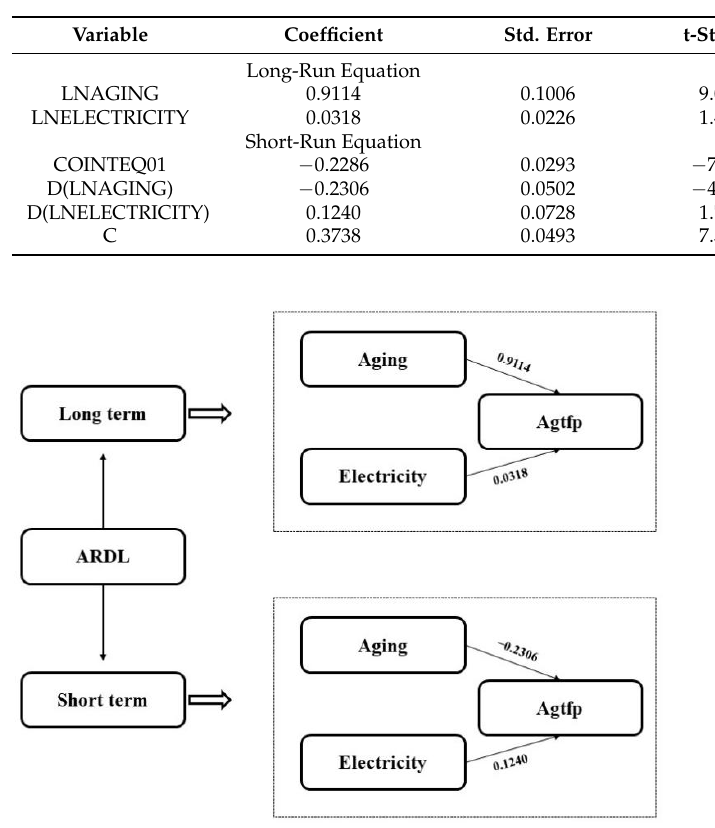
Figure 2. ARDL analysis result.